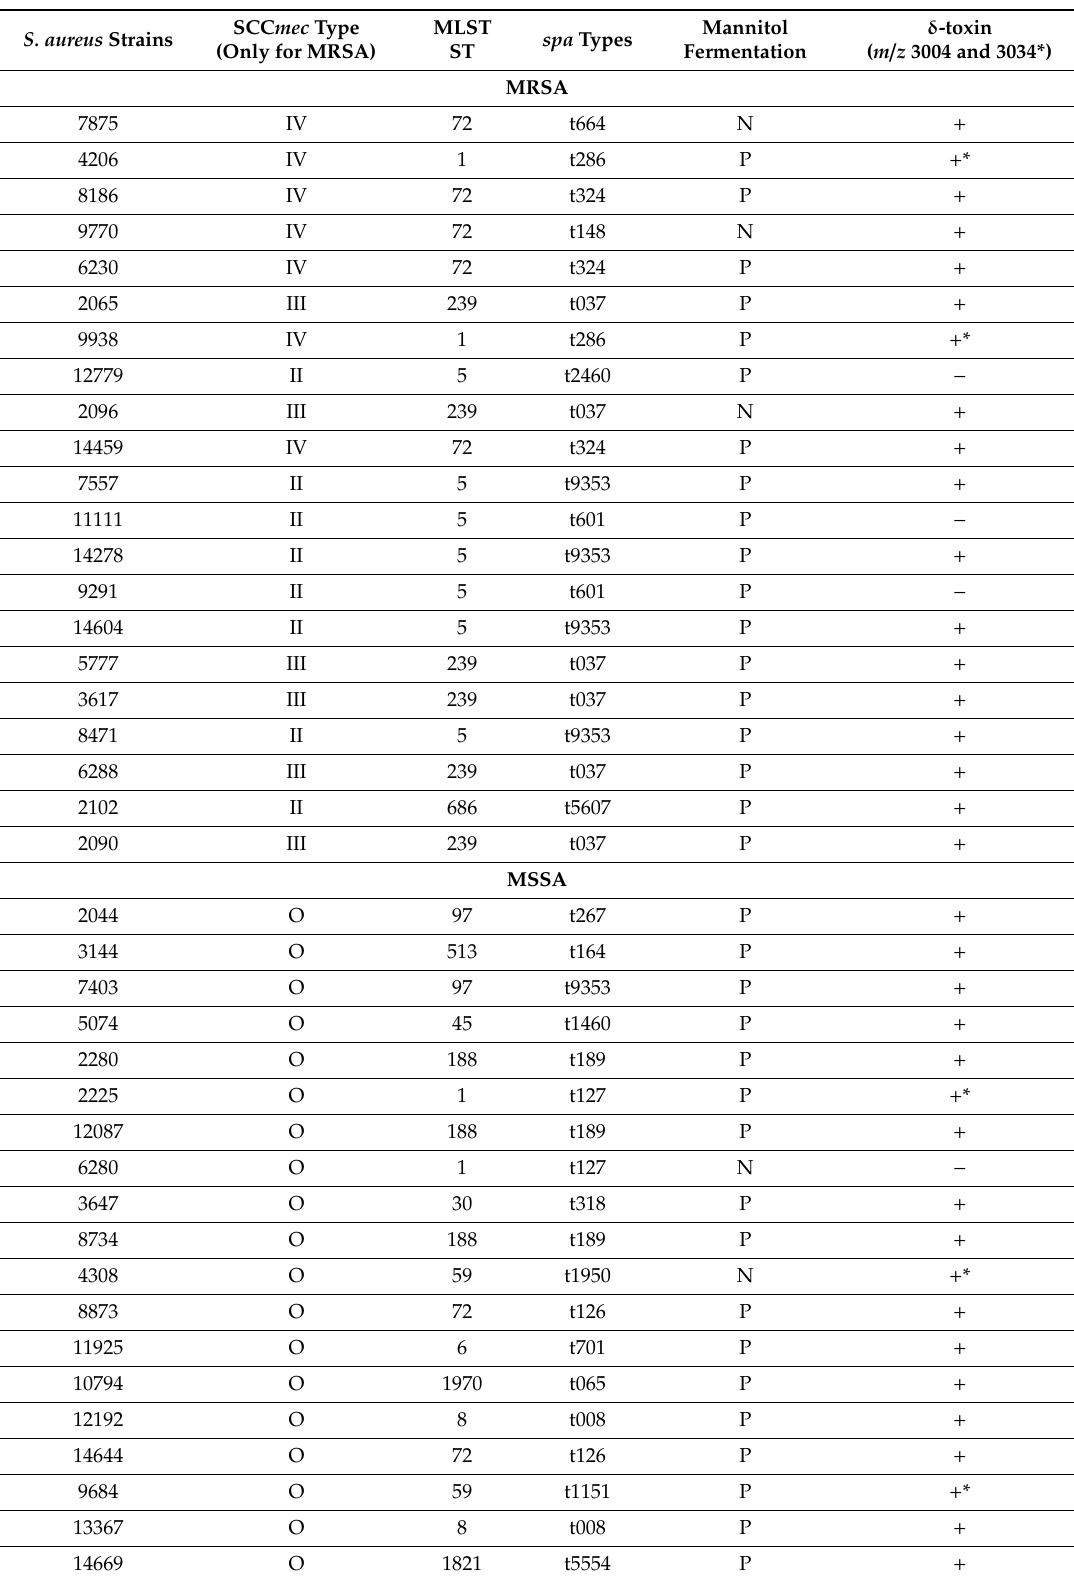
Table 1. Phenotypic and genotypic characteristics of the S. aureus strains used in this study. S. aureus